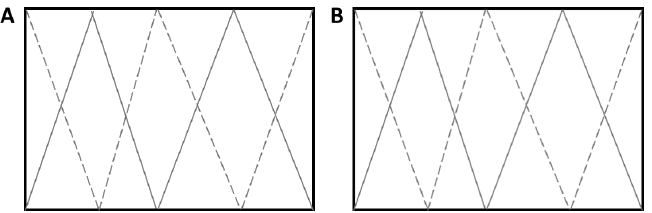
Figure 2. Schematic overview of the grass sampling (pasture A and pasture B) in the faecal removal and harrowing studies. ( A ) Pasture A had faeces removed/was harrowed and ( B ) pasture B served as the control. Grass was collected by walking over each pasture in a zigzag pattern in two directions (dashed vs. solid line). A pinch of grass, approximately 0.5 cm in diameter, was cut close to the ground every seventh